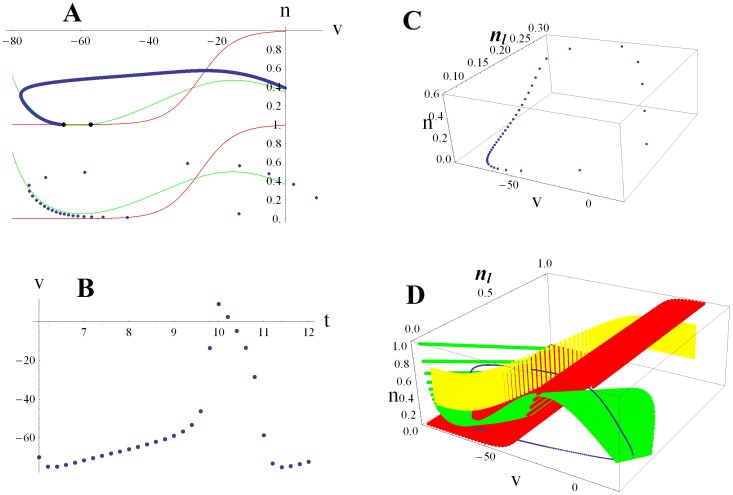
Trajectories for a 2d versus 3d saddle node on invariant circle (SNIC) bifurcation.A. Phase plane plots for a 2d SNIC that show the trajectory (blue) with a fast voltage variable v plotted against a slower n, the high threshold voltage-gated potassium conductance open probability. dv/dt = 0 (green) is the voltage nullcline; when the trajectory goes above it then dv/dt<0 so that the voltage decreases. Left of the red curve dn/dt<0 so that the open probability of the potassium conductance decreases. When input current is small the system is poised below the bifurcation so that the trajectory ends on the stable node (black dot upper plot). As input current increases the voltage nullcline is raised (green curve lower plot) until the stable node merges with the saddle node to its right and both disappear. The trajectory then starts orbiting in a series of action potentials (blue dots spaced at equal time intervals in the n vs. v plot. B. v vs. t plot showing the bottleneck where the spiking trajectory slows down (closely spaced blue dots in parts A and B where v increases relatively slowly). Further small increases in input current slightly raise the voltage nullcline, which has the effect of rapidly increasing the spike rate. C. 3d SNIC in which the rate of increase of spike rate is slowed by adding a slow low threshold voltage-gated potassium conductance to the generic 2d SNIC. When this conductance with gating variable nl is included, the spiking trajectory gets trapped for a longer time in the bottleneck, being mainly confined to the n
, 
nl plane with little increase in the v direction. Slowdown in the rate of voltage increase is most easily seen by observing that the number of dots in the bottleneck approximately doubles as compared to part A (same input current and time intervals). D. Null surfaces corresponding to 3d SNIC: dv/dt = 0 (green), dn/dt = 0 (red) and dnl/dt = 0 (yellow) show the turning points of this 3 dimensional trajectory (blue line). The slowed trajectory gets wrapped close behind the green null surface where dv/dt is positive, but small due to nl turning off slowly.